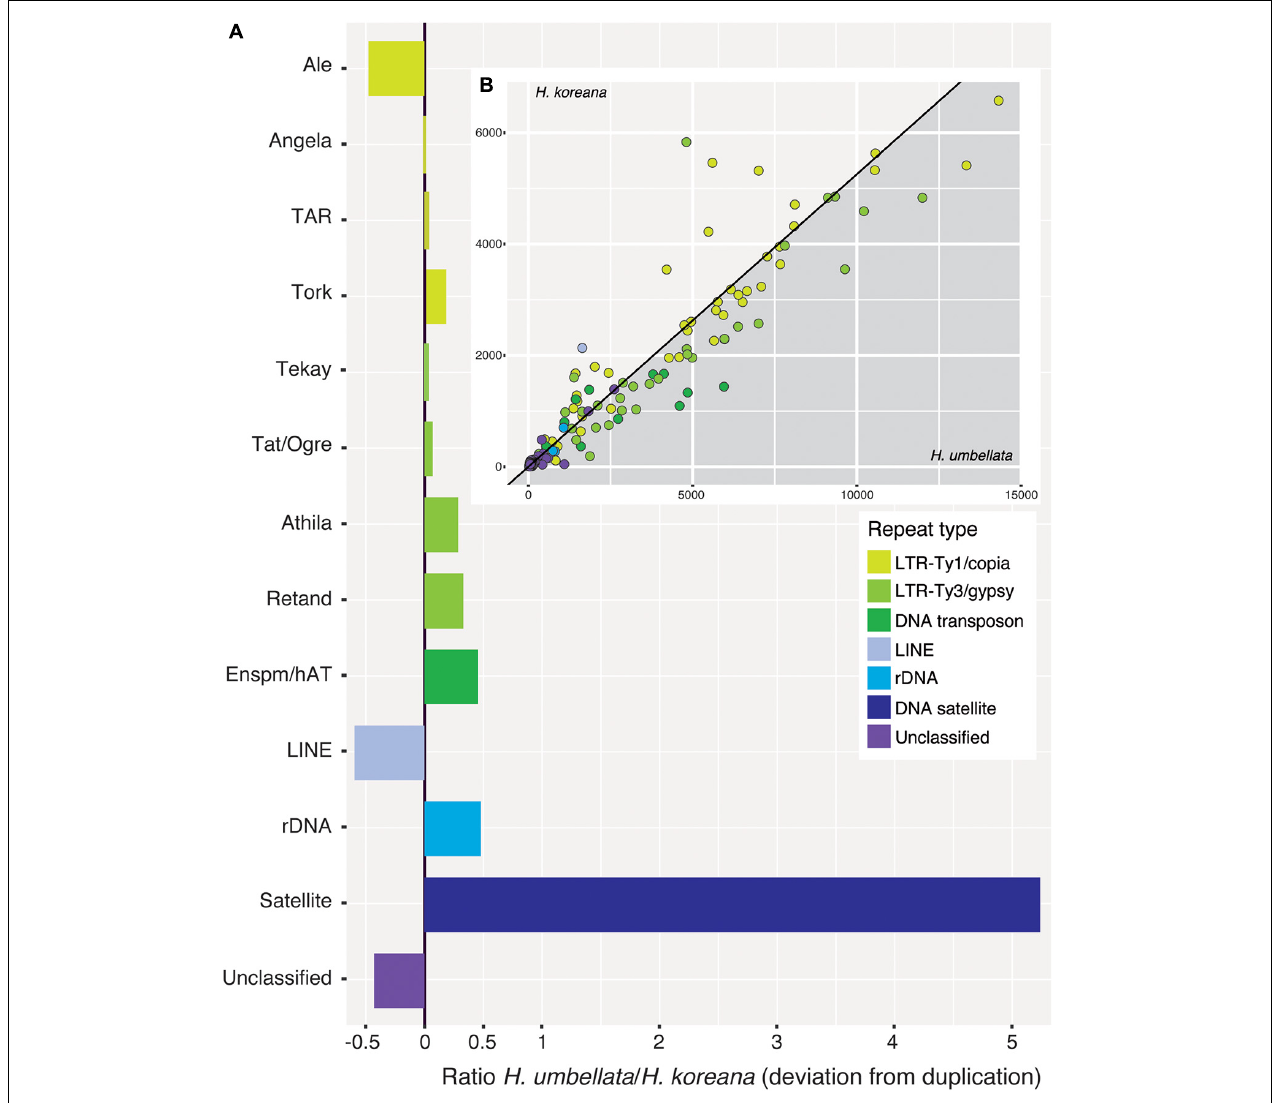
FIGURE 4 | (A) Ratios of incidence of shared repeat clusters from the comparative analysis ( Heloniopsis umbellata / H. koreana ). A ratio of zero indicates clusters present in the same genomic proportion in both species. (B) (inset) Pairwise scatterplot of the number of reads from each species in shared repeat clusters from the comparative analysis (excluding satellite DNA). The slope of the line is equal to the ratio of the genome sizes of the two species (i.e., 1.9). Dots falling along the line are present in the same genomic proportions in the two